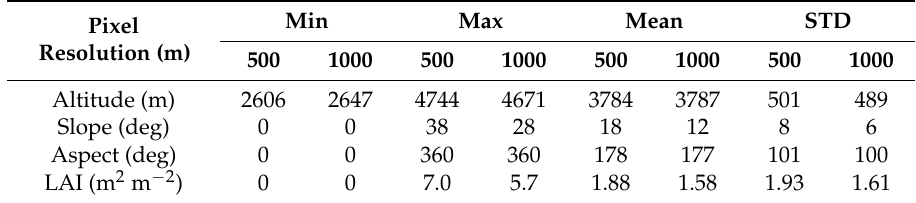
Table 1. Comparisons of topographic factors and at 500 m and 1 km.